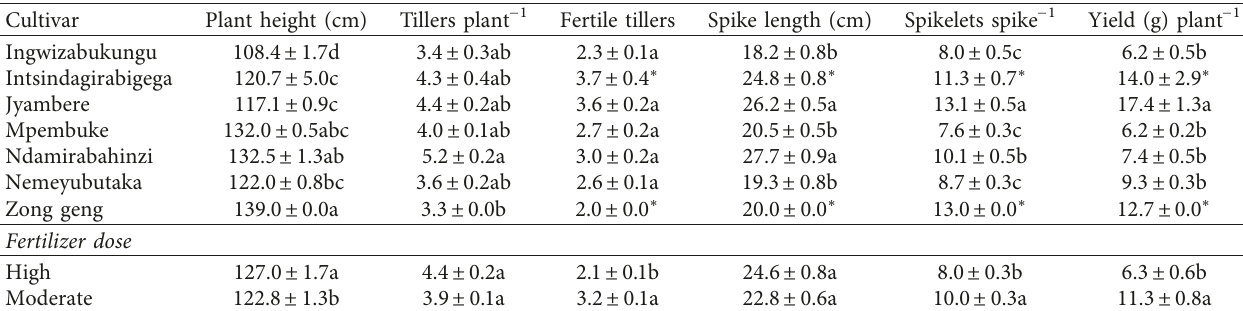
Table 6: Yield and yield component variation between rice cultivars and fertilizer